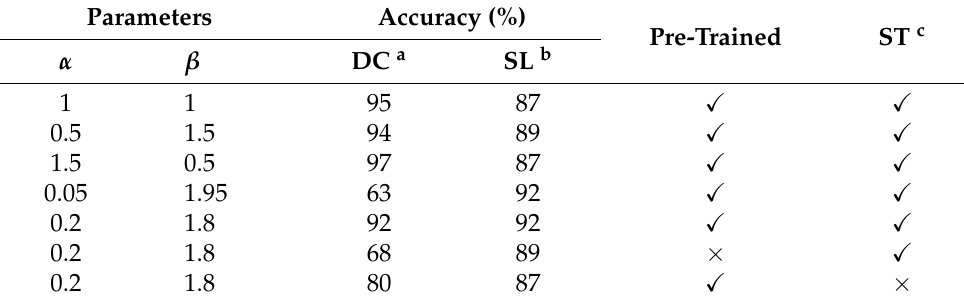
Table 8. Training results of the ABERT